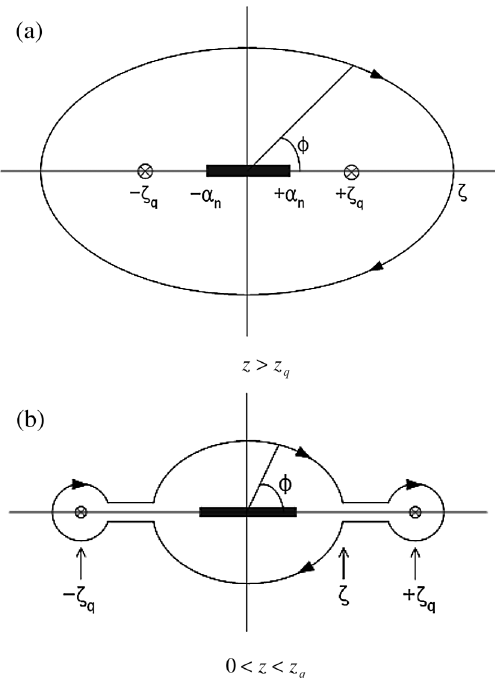
FIG. 3. Integration paths for evaluating transient